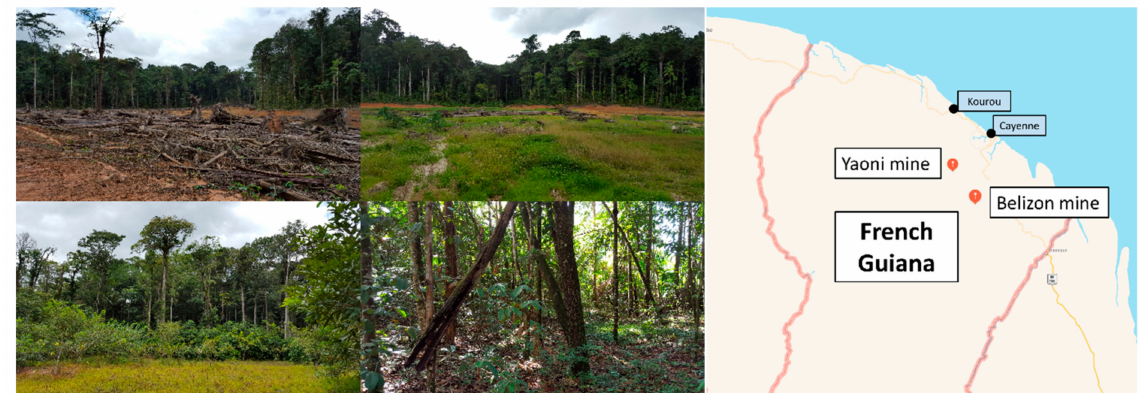
Figure 1. Illustration of some examples of different stages of ecological restoration on former Guyanese gold mining sites and geographical location of the Yaoni and Belizon mines in French Guiana. Non-restored site ( top left ), ecological restoration with herbaceous species after 3 years (( top right ), Lyc), ecological restoration with fabaceous species after 3 years (( bottom left ), Cli), ecological restoration with fabaceous species after 18 years (( bottom right ), Mix). The pictures were taken during a second sampling campaign in April 2016 at sites undergoing ecological